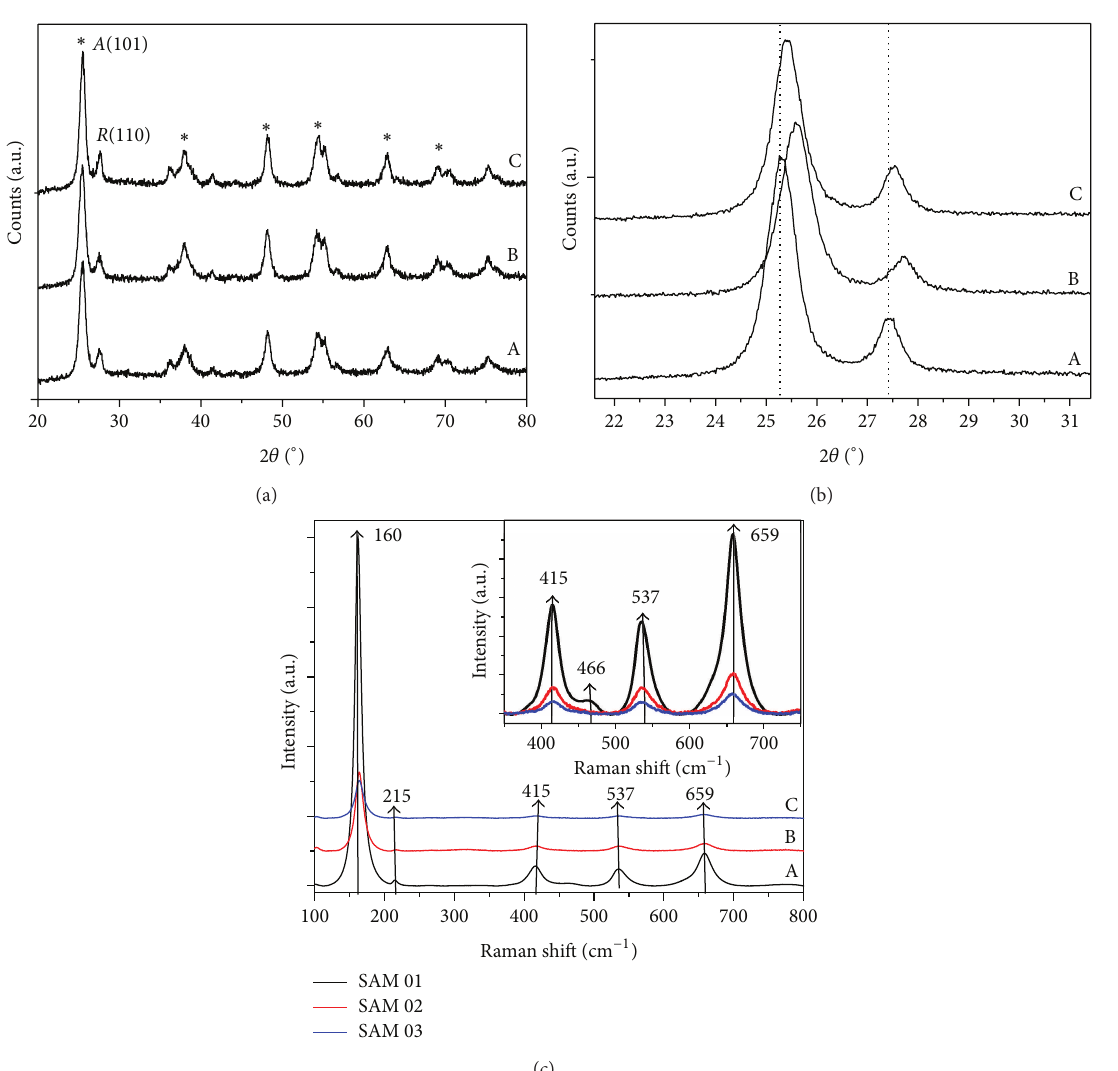
Figure 2: (a) X-ray diffraction spectra of TiO 2 ( 𝐴 , ∗ ) and rutile ( 𝑅 ) between 20 to 80 ∘ , 0,02 ∘ /min. (b) X-ray diffraction spectra between 20 and 32 ∘ with the shift of main diffraction peak of TiO 2 anatase and rutile. (c) Raman spectra between 100 and 800cm −1 . Insert: Raman spectra between 350 and 7500 cm −1 of (A) SAM 01, (B) SAM 02, and (C) SAM